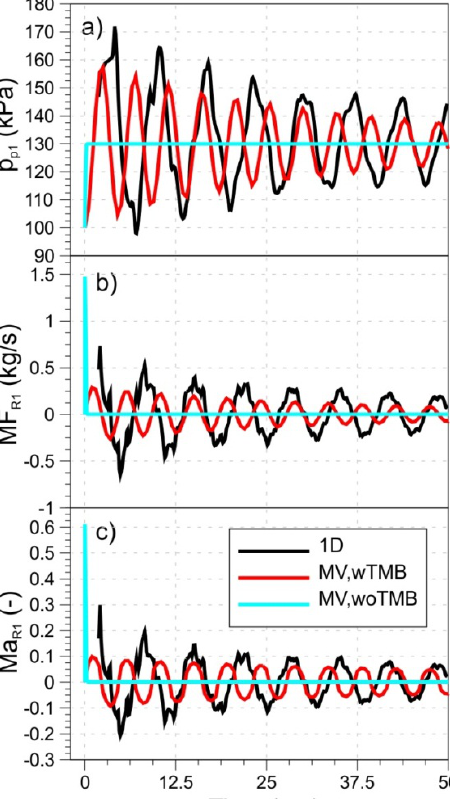
Figure 5. A1-R1-P1-R2-A2: traces of ( a ) pressure in P1 and ( b ) the mass flow and ( c ) the Mach number through the middle of the R1 calculated with: (1) the mean-value model without the TMB (MV,woTMB); (2) the mean-value model with the TMB (MV,wTMB); and (3) the 1D simulation tool capable of capturing the wave dynamics in the pipes